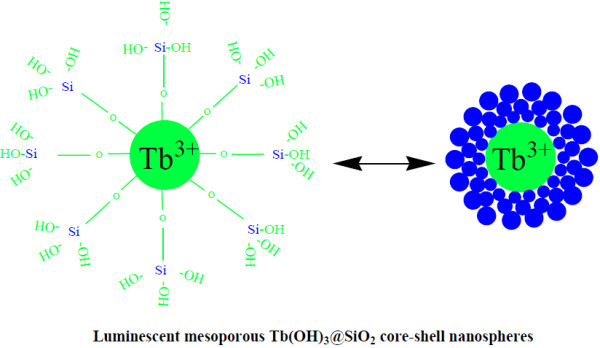
Schematic diagram of the synthesis process of luminescent mesoporous Tb(OH)3@SiO2core-shell nanospheres.